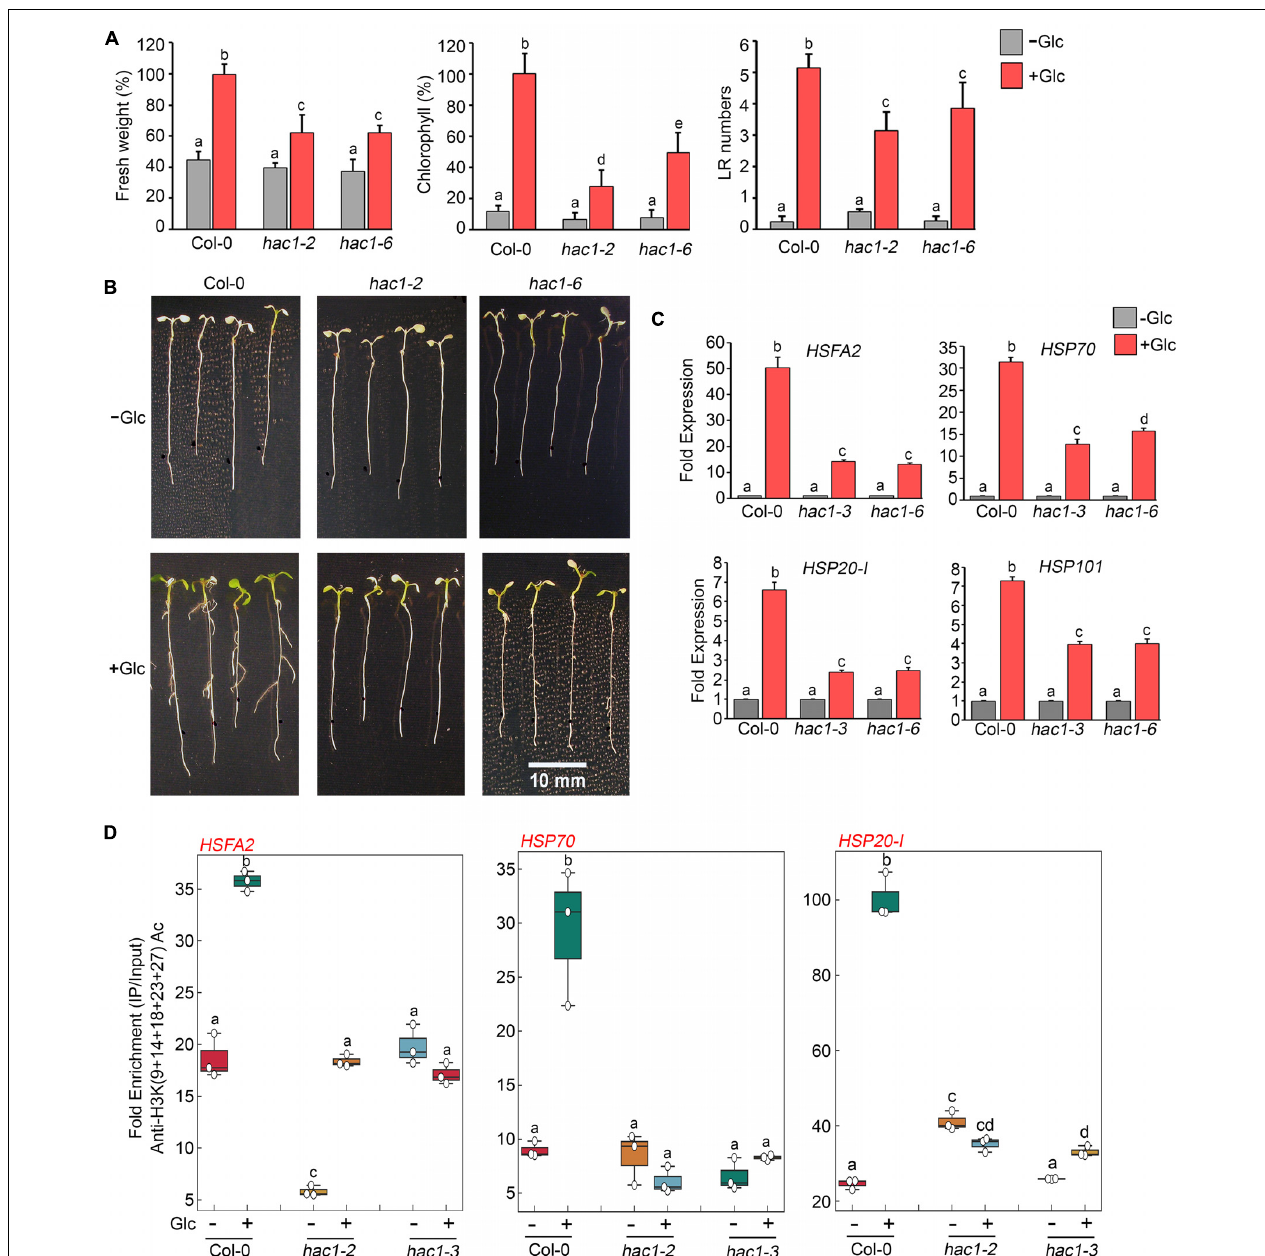
FIGURE 6 | Glc-TOR-mediated HS response is governed through HAC1. (A) Percentage measurement of fresh weight, Chl content, and LR numbers of Arabidopsis Col-0 and hac1 mutants after HS. (B) HS phenotype of Arabidopsis Col-0 and hac1 seedlings primed with Glc (167 mM). Five-day-old 0.5X MS-grown Arabidopsis seedlings treated without or with Glc and subjected to HS. HS was applied as 1 h_37 ◦ C, 2 h_22 ◦ C, and 2.5 h_45 ◦ C, followed by recovery at 3–4 days_22 ◦ C. Physiological analysis was performed on four (Fresh weight and Chlorophyll) and three (Lateral root number) independent biological replicates ( n = 3). Bar plots represent mean values, and error bars denote SE. Different letters denote statistical differences at p < 0.05 as assessed by one-way ANOVA and Tukey’s HSD post hoc test. (C) RT-qPCR expression of HS genes in Col-0 and hac1 mutants in response to Glc (167 mM). RT-qPCR analysis was performed on three independent biological replicates ( n = 3). Bar plots represent mean values, and error bars denote SE. Different letters denote statistical differences at p < 0.05 as assessed by one-way ANOVA and Tukey’s HSD post hoc test. (D) ChIP-qPCR showing enrichment of histone H3K Ac (9 + 14 + 18 + 23 + 27) at the promoters of HS gene-encompassing HSEs in Col-0 and hac1 mutants. The amount of Immuno-precipitated promoter DNA was calculated by comparing samples treated without or with an anti-Histone H3K (9 + 14 + 18 + 23 + 27) acetyl antibody. Ct values without and with antibody samples were normalized by input control. In panels (C,D) , 7-day-old 0.5X MS-grown Col-0 and hac1 seedlings were subjected to 24-h Glc starvation in MS medium without Glc and then supplied with 3-h Glc (167 mM) treatment. ChIP-qPCR analysis was performed on three technical replicates ( n = 3) from a single representative experiment. The experiment was independently repeated two times (biological replicates; n = 2). Different letters denote statistical differences at p < 0.05 as assessed by one-way ANOVA and Tukey’s HSD post hoc test.